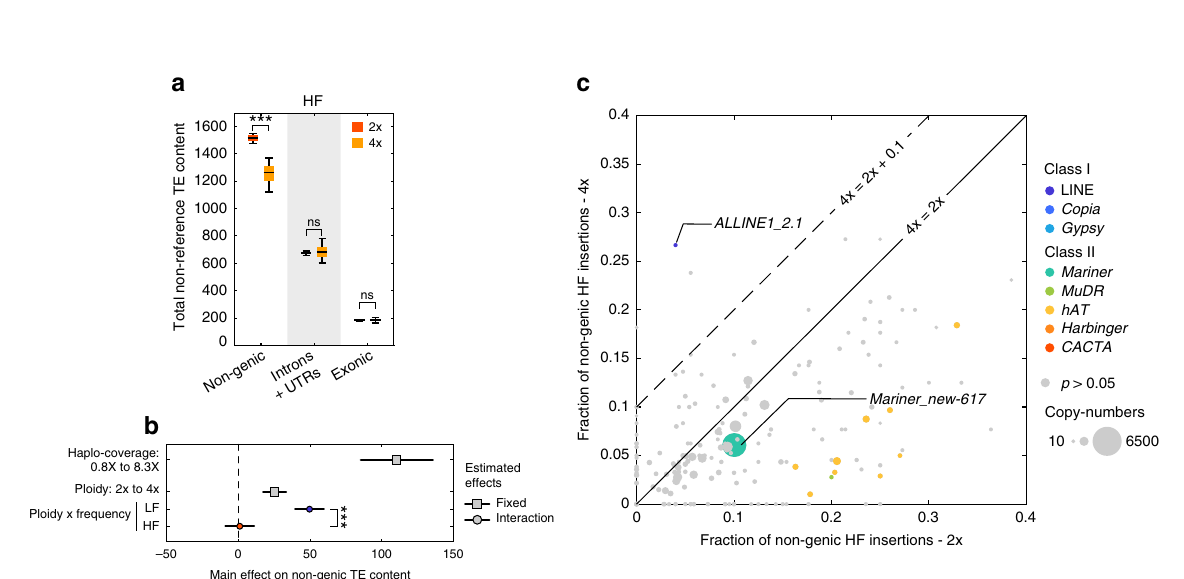
Fig. 3 Absence of genome-wide or family speci fi c transposition burst hallmarks in autotetraploids. a Number of TE insertions carried by 100 individuals by category (non-genic, introns and UTRs, exonic) in diploids and tetraploids at high-frequency (HF) with standard deviations across 100 random samples and p -value of t -test between ploidies. Boxplot center lines, median; box limits, upper and lower quartiles; whiskers, 9th and 91st quantiles. b Estimated MLM effects and interaction effects of haplo-coverage, ploidy, and insertion frequency on non-genic TE content. Horizontal lines indicate 95% con fi dence intervals for each effect value. p -values for each coef fi cient corresponds to the t -statistic of the hypothesis test that the corresponding coef fi cient is equal to zero or not. c Fraction of non-genic insertions at high-frequency (HF) in tetraploids versus diploids by TE family. TE families with χ 2 p -values < 0.05